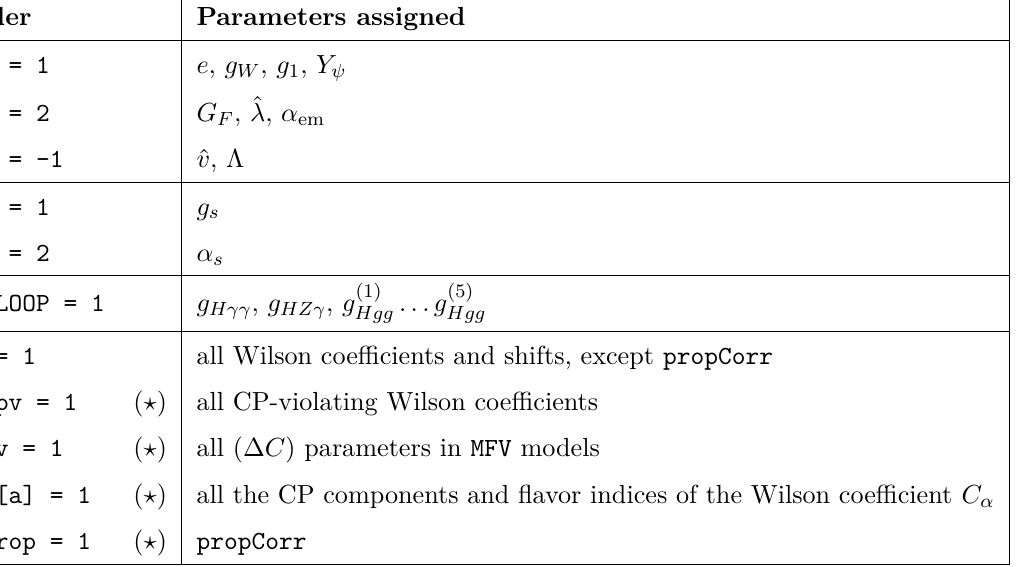
Table 7 . Interaction orders defined in the SMEFTsim UFO models. Those marked with a ( ? ) are new in version 3.0. The string [a] stands for a generic root name of a Wilson coefficient, as listed in appendix